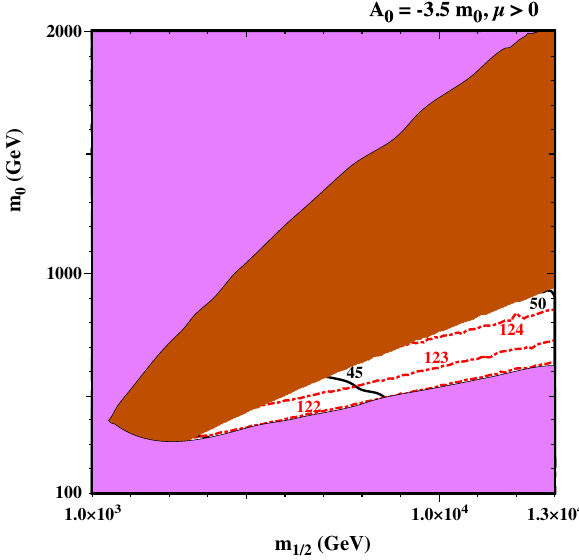
Fig. 3 Higgs mass contour plot in the plane ( m 1 / 2 - m 0 ) for the “ small λ λ = ( 0 . 0002 , 0 . 6 , 0 . 6 ) .Thecolourcodeisthesame N ”scenariowith N as in Fig. 2, except in the white region that represents the case where the sneutrino is the LSP in this case. Red dashed contours account for the Higgs mass (in GeV), while the black lines represent the value of tan β whereas in the remaining white area, the neutralino is the LSP. The black contours represent the values of tan β neces- sary to achieve the universal conditions (seen here to lie in the range of tan β ∼ 40 − 50), while the red dot-dashed contours show the SM-like Higgs mass. We notice that the experimen- tally observed Higgs mass is not achieved in the allowed region. Indeed, the highest value for the SM-like Higgs mass is around 124 GeV for large values of tan β ( ∼ 50), although this region remains acceptable if we consider a ± 3 GeV uncertainty in the calculation of the Higgs mass. It has been pointed out in Ref. [30] that the stau-neutralino co- annihilation strip in the CNMSSM extends only up to values of m 1 / 2 of the order of a few TeV, which roughly corresponds (cid:2) 1 TeV. In this plot, this region is excluded due to to m ˜ τ 1 constraints in the Higgs sector, as explained